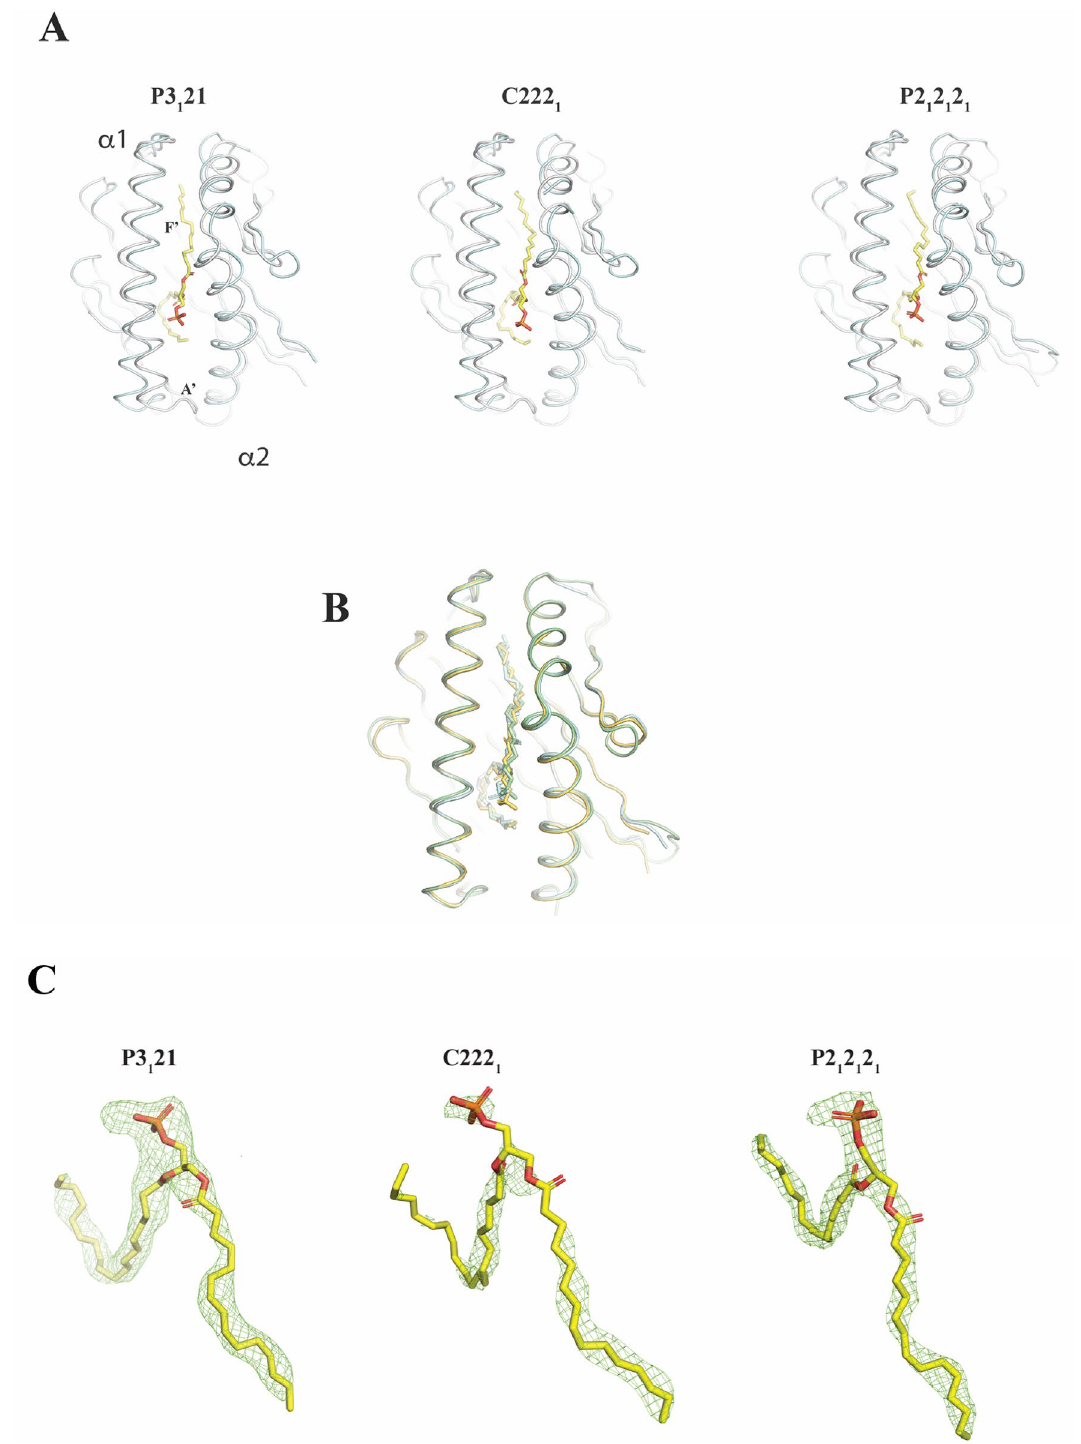
Figure 4. Superposition of EPCR and CD1d crystal structures. ( A ) Ribbon diagram showing a top view of human CD1d structure (light gray), extracted from coordinates in Protein Data Bank deposition 4EN3, superposed with EPCR structures (palecyan colored) crystallized in space groups P3 1 21 (left), C222 1 (middle) and P2 1 2 1 2 1 (right). A phospholipid molecule is shown in sticks mode, where the outer most polar group is not shown. ( B ) Superposition of EPCR molecules crystallized in the three different groups shown in ( A ). Colors are palegreen, yelloworange and palecyan for molecules in P3 1 21, C222 1 and P2 1 2 1 2 1 space groups, respectively. ( C ) Heterogeneity in the EPCR lipid binding cleft. Fo-Fc difference omit maps (shown as green colored meshes) were generated through refinement using full EPCR, ligands and water coordinates and omitting the lipid molecule. Given the lack of electron density signal, the phospholipid molecule does not include the group (-choline, -ethanolamine, -serine or -inositol) linked to the phosphate. All figures were prepared with PyMOL version